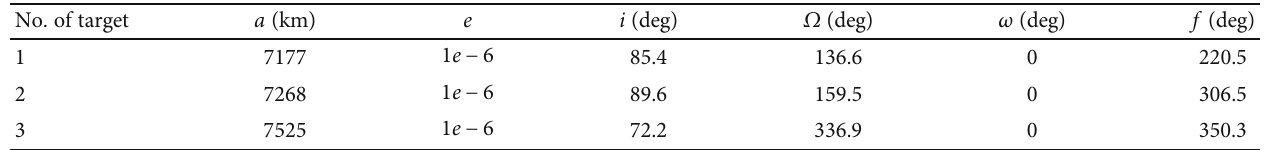
Table 3: The initial orbital elements of